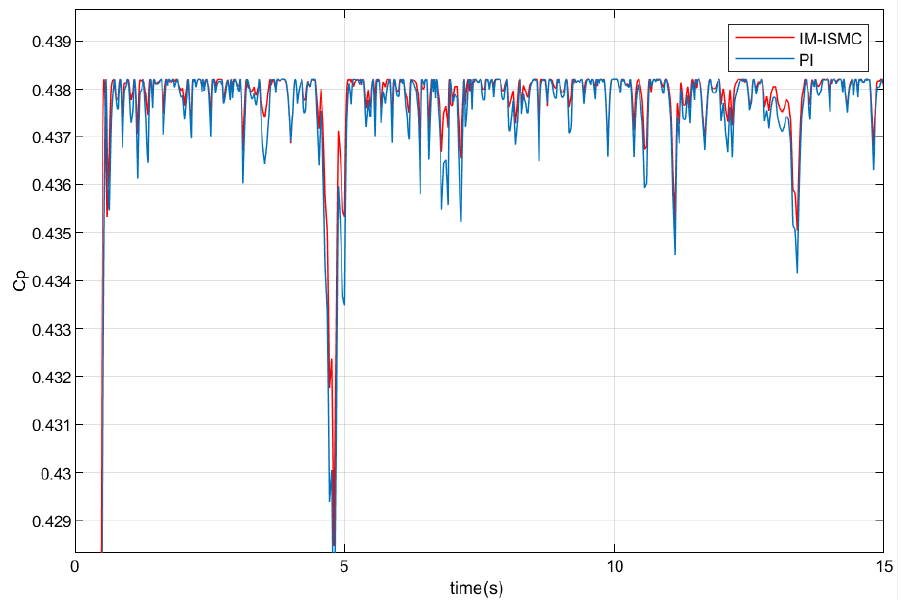
Figure 18. Simulation results of power